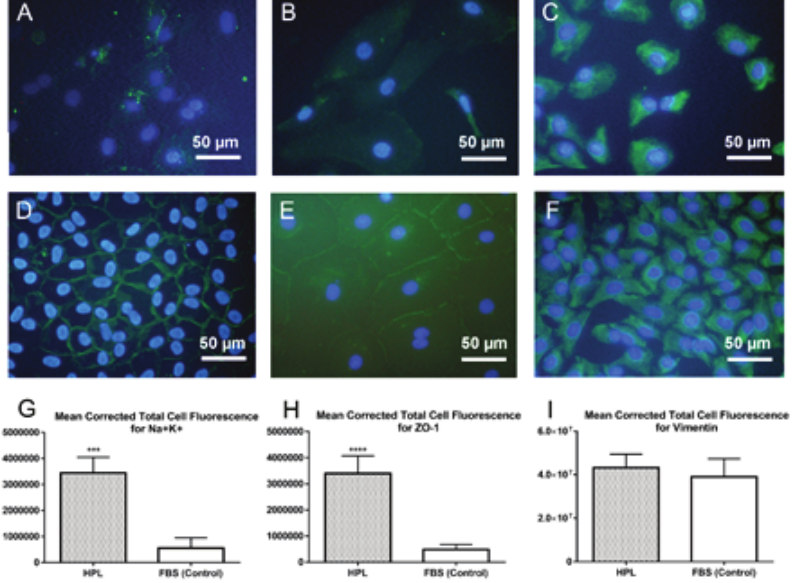
Figure 4. Expression of Na+/K+-ATPase, ZO-1 and vimentin proteins in the HCECs cultured in 20% HPL and 20% FBS, as the control group, after five days of treatments. (A) A merged FITC-Na+/K-ATPase antibody and DAPI image in the cells treated with 20% FBS. (B) A merged FITC-ZO-1 antibody and DAPI image in the cells treated with 20% FBS. (C) A merged FITC- vimentin antibody and DAPI image in the cells treated with 20% FBS. (D) A merged FITC-Na+/K-ATPase antibody and DAPI image in the cells treated with 20% HPL. (E) A merged FITC-ZO-1 antibody and DAPI image in the cells treated with 20% HPL. (F) A merged FITC-vimentin antibody and DAPI image in the cells treated with 20% HPL. Mean CTCF values of (G) Na+/K+-ATPase and (H) ZO-1 protein expressions show a significant increase in the HPL-treated HCECs as compared to the control group (*** P < 0.001 and **** P < 0.0001, respectively). (I) Means of CTCF for vimentin expression were not significantly different between the two